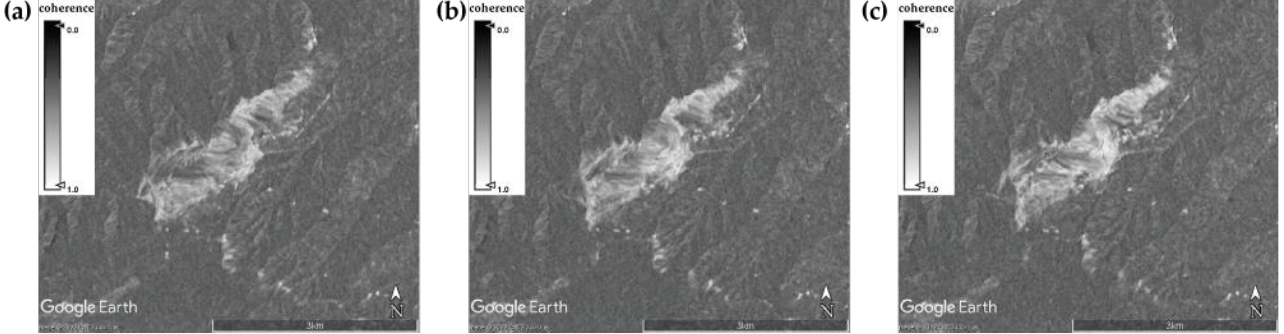
Figure 2. Annually averaged 12-day coherence images of the study area in ( a ) 2018, ( b ) 2019, and ( c ) 2020.